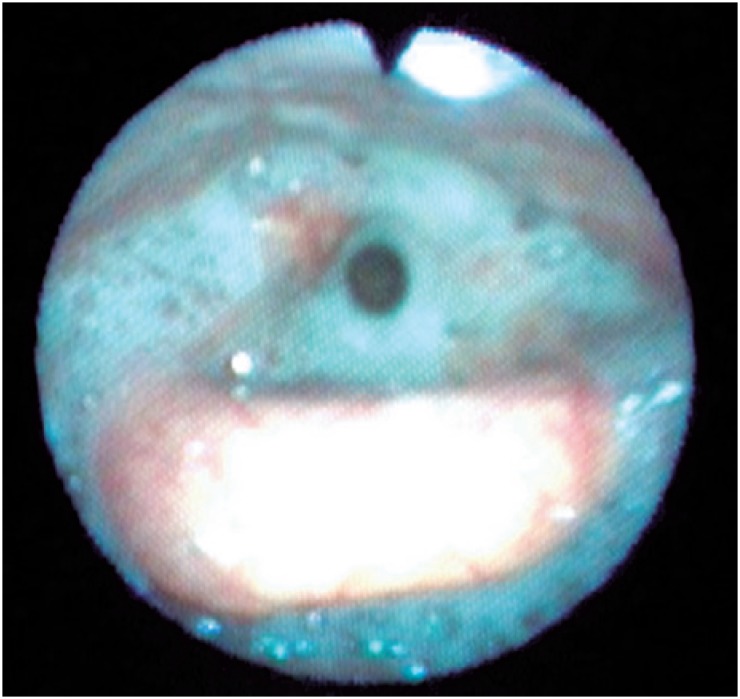
Videoendoscopia da deglutição: estase de saliva em valéculas, seios piriformes, e região retrocricoídea, com penetração e aspiração laringotraqueal